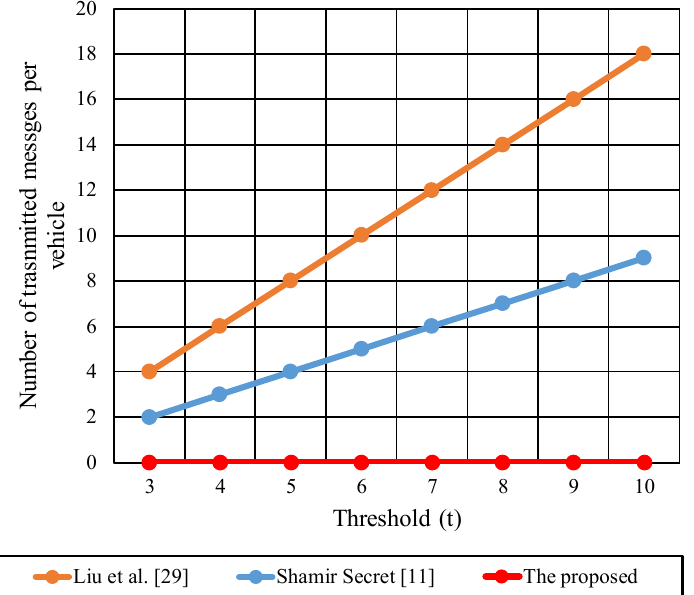
Figure 8. The transmitted messages per each participant vehicle during the key reconstruction phase.